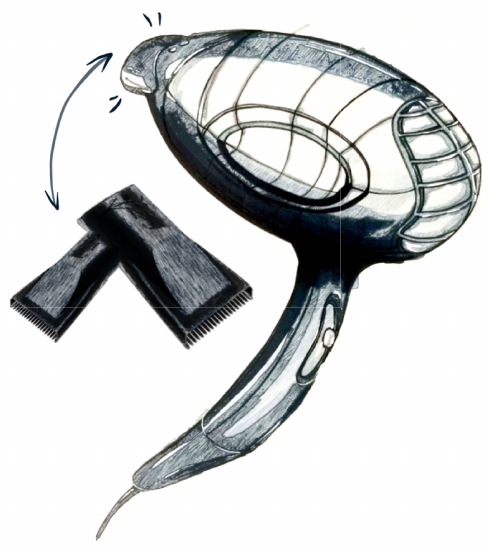
Figure 11. The sketch of hair dryer inspired by